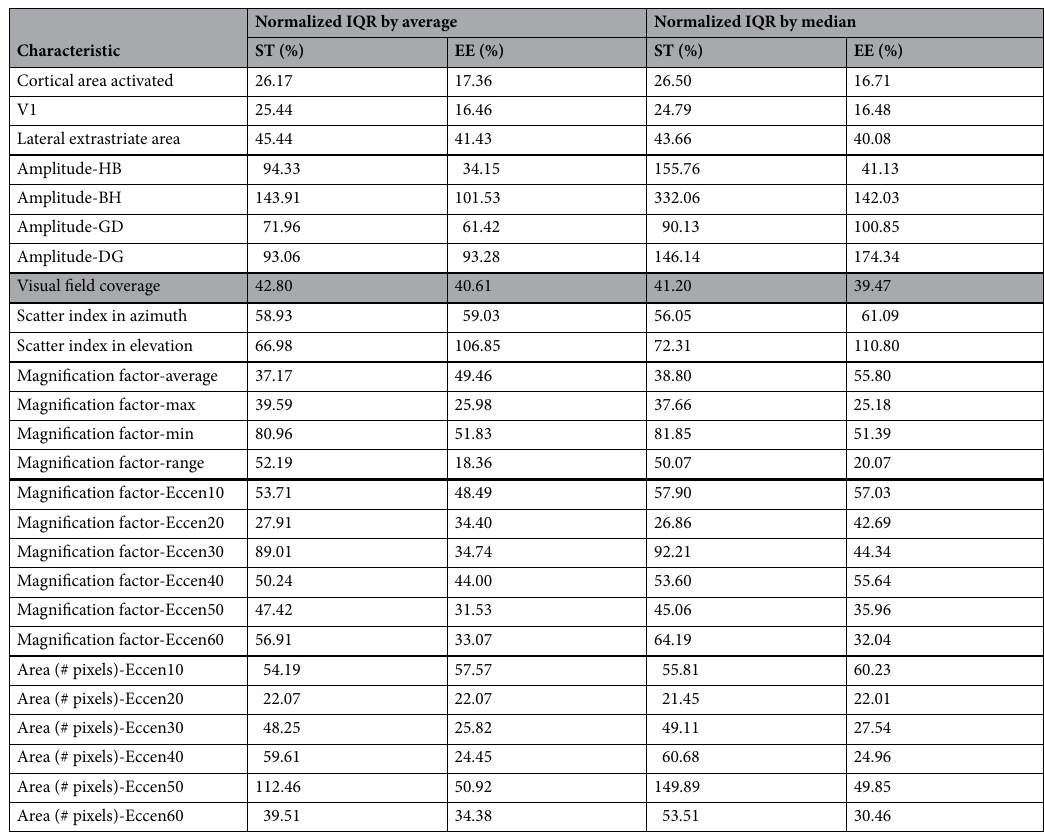
Table 2. Normalized population ranges for standard and mice that lived in an enriched environment.